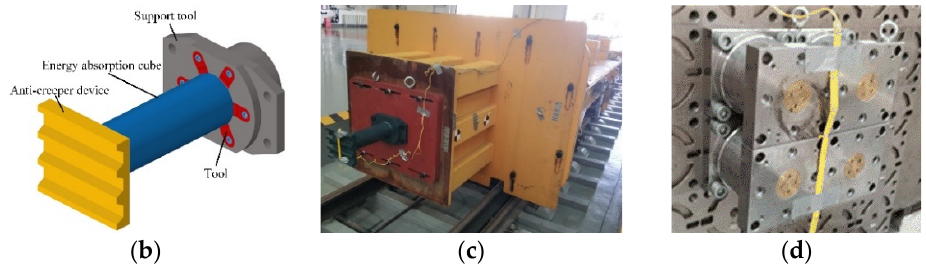
Figure 1. ( a ) Layout schematic, ( b ) cutting-type energy-absorbing structure, ( c ) test trolley, and ( d ) force cells.